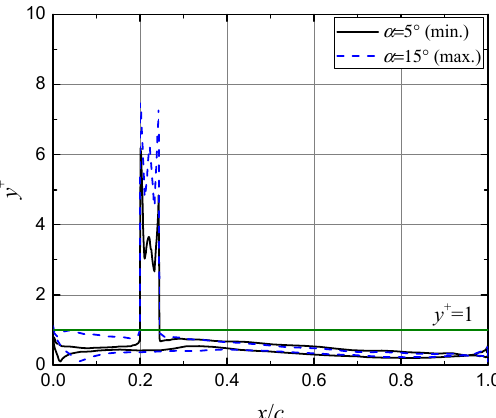
Figure 3. Sensitivity of pressure distribution to the far-field distance. α = 15 ° without VGs.